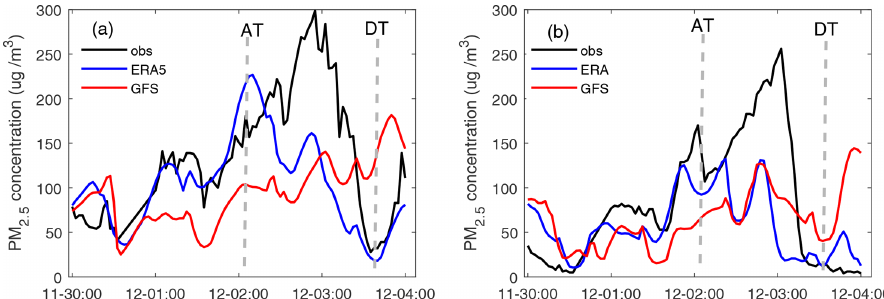
Figure 2. Time series of the dry PM 2 . 5 concentrations at (a) Baoding station (Hebei Province) and (b) Dongsi station (Beijing) of observa- tions and simulations initialized by ERA5 and GFS meteorological data during the period between 30 November and 4 December 2017. The accumulation time (AT) and dissipation time (DT) are marked by dashed